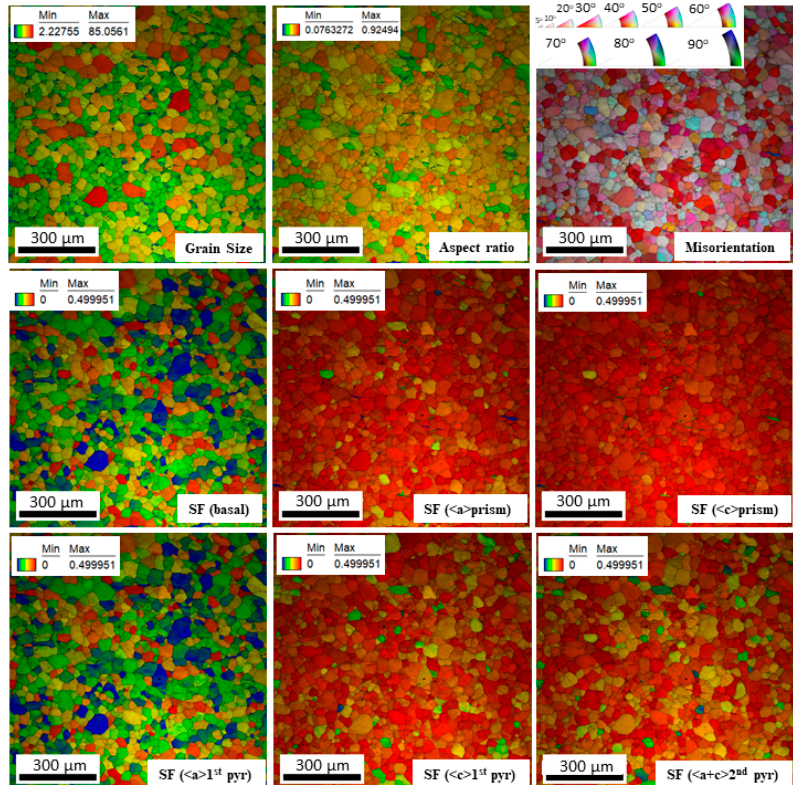
Figure 1. ( a ) Inverse pole figure (IPF) maps, ( b ) grain size distributions, ( c ) grain aspect ratio distri- bution, and ( d ) pole figures (PF) of the as-received pure Mg and AZ31 Mg alloy, respectively. ( e ) Room temperature tensile curves of the as-received pure Mg and AZ31 Mg alloy. ( f ) Kernel average misorientation (KAM) maps, and ( g ) KAM distributions of the 5%-deformed pure Mg and 10%- deformed AZ31 Mg alloy, respectively. The scale bar interested in the KAM map of the two materi- als in Figure 1f represents misorientations from 0° to 5° of neighboring points in these maps. The profile in Figure 1g shows the KAMs that are higher than 1° (1–5°).